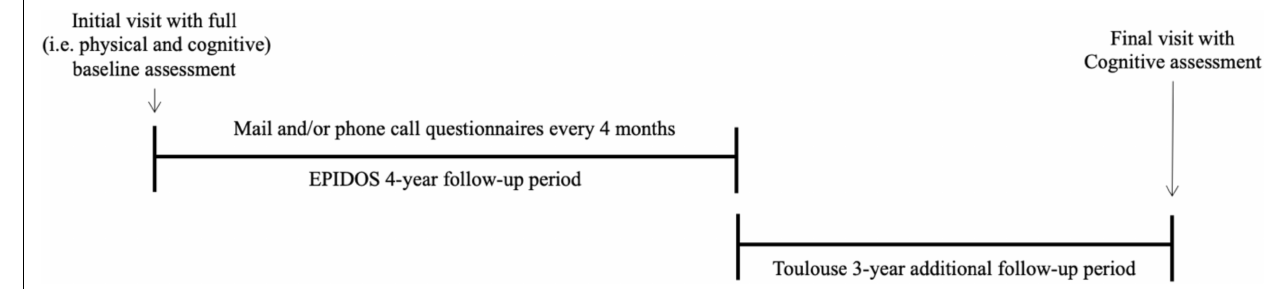
FIGURE 1 | Overview of the follow-up